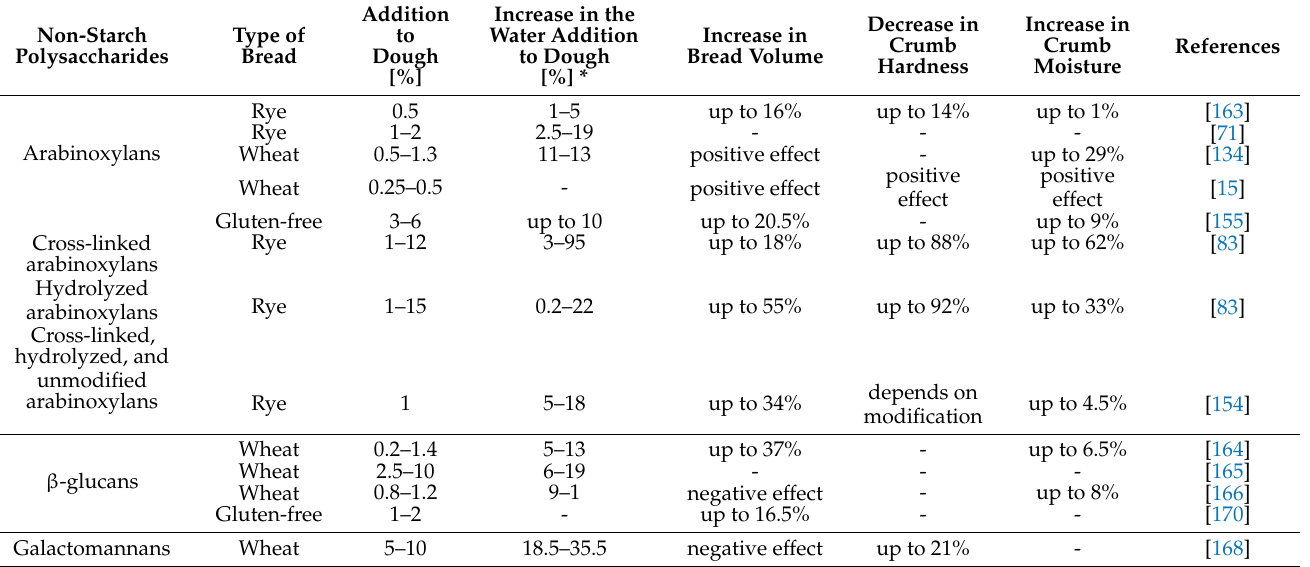
Table 3. Effect of the addition of NSPs on the water added to the dough and on quality features of